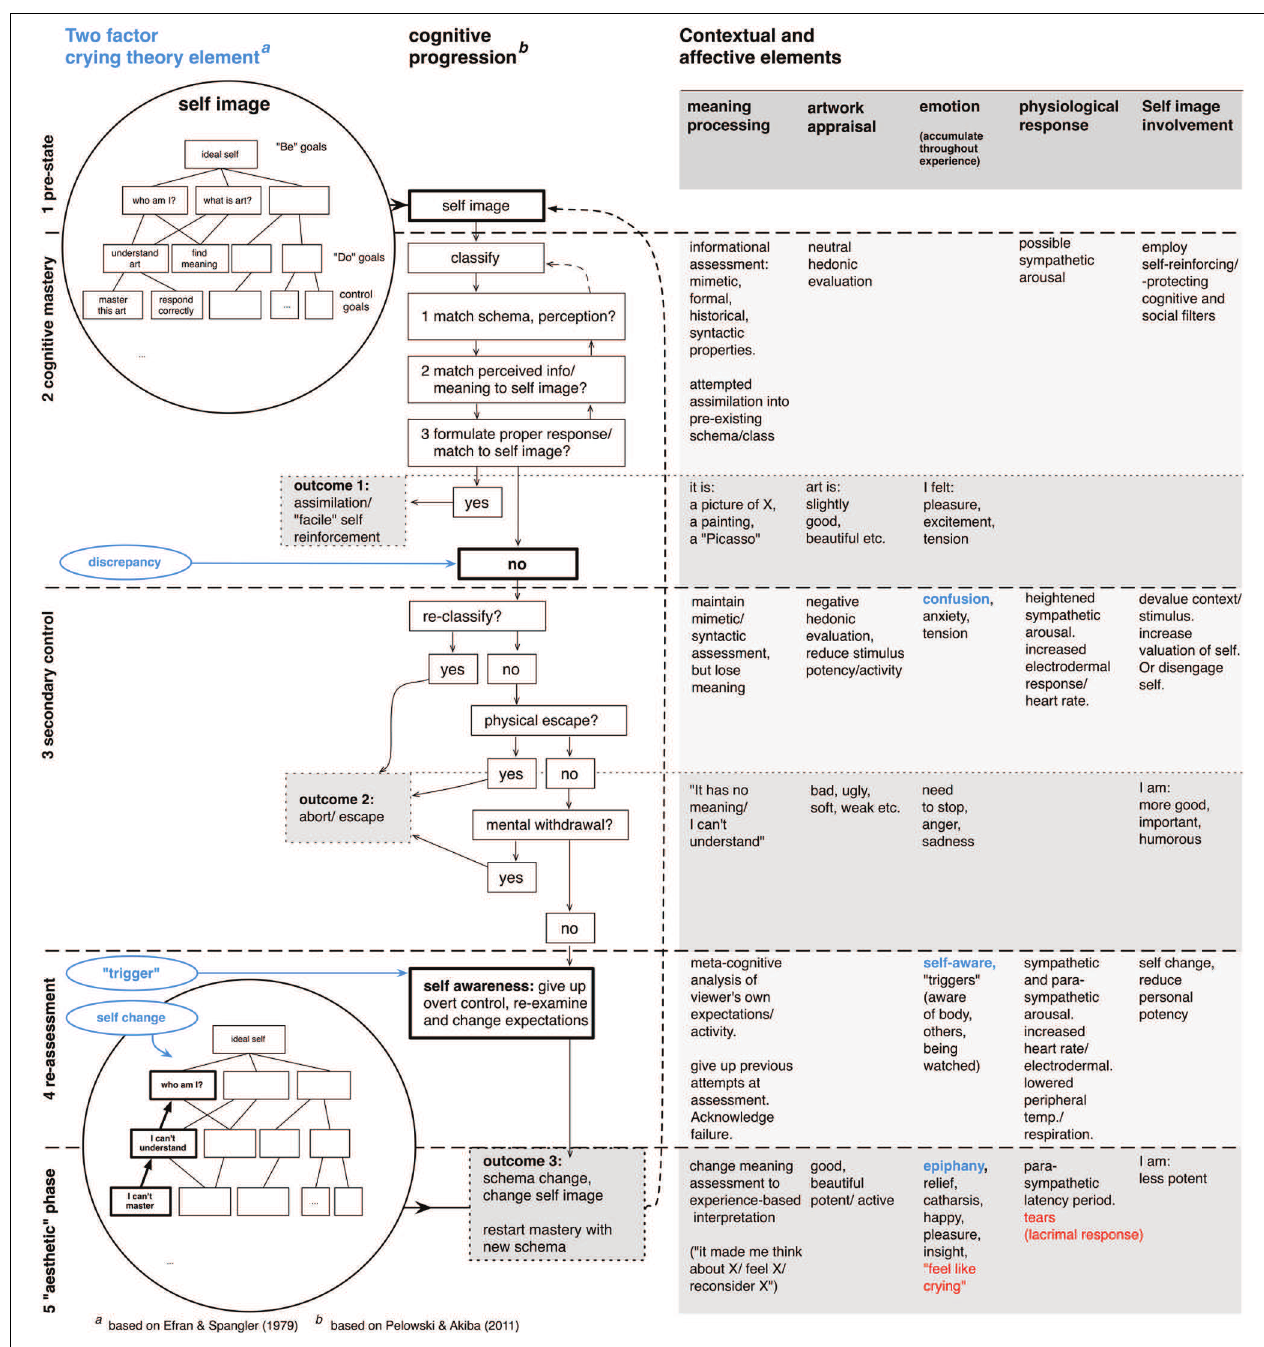
FIGURE 4 | Cognitive Flow Model of insightful/“aesthetic” experience with hypothesized factors for each stage. Posited emotion, artwork appraisals, mode of meaning assessment, physiological reactions, and self image-related processes are shown on the right side,